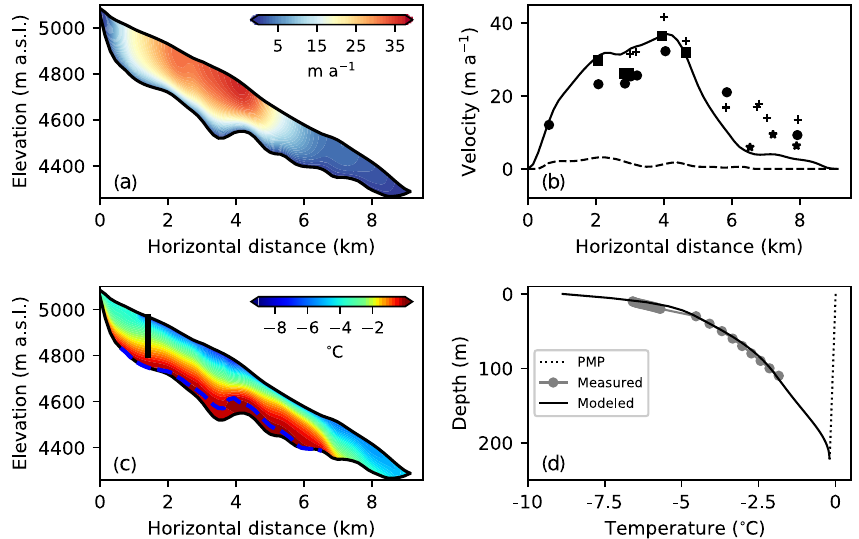
Figure 9. Comparison of measured and transiently modelled horizontal velocities and ice temperatures of LHG12. (a) Modelled distribution of horizontal ice velocity. (b) Measured (markers) and modelled surface (solid line) and basal (dashed line) horizontal velocities along the CL. (c) Modelled distribution of ice temperature. The blue dashed line indicates the CTS position, and the black bar indicates the location of the deep ice borehole. (d) Measured (dots) and modelled (solid line) ice temperature profiles in the deep borehole. Pressure melting point is indicated by the dotted line.